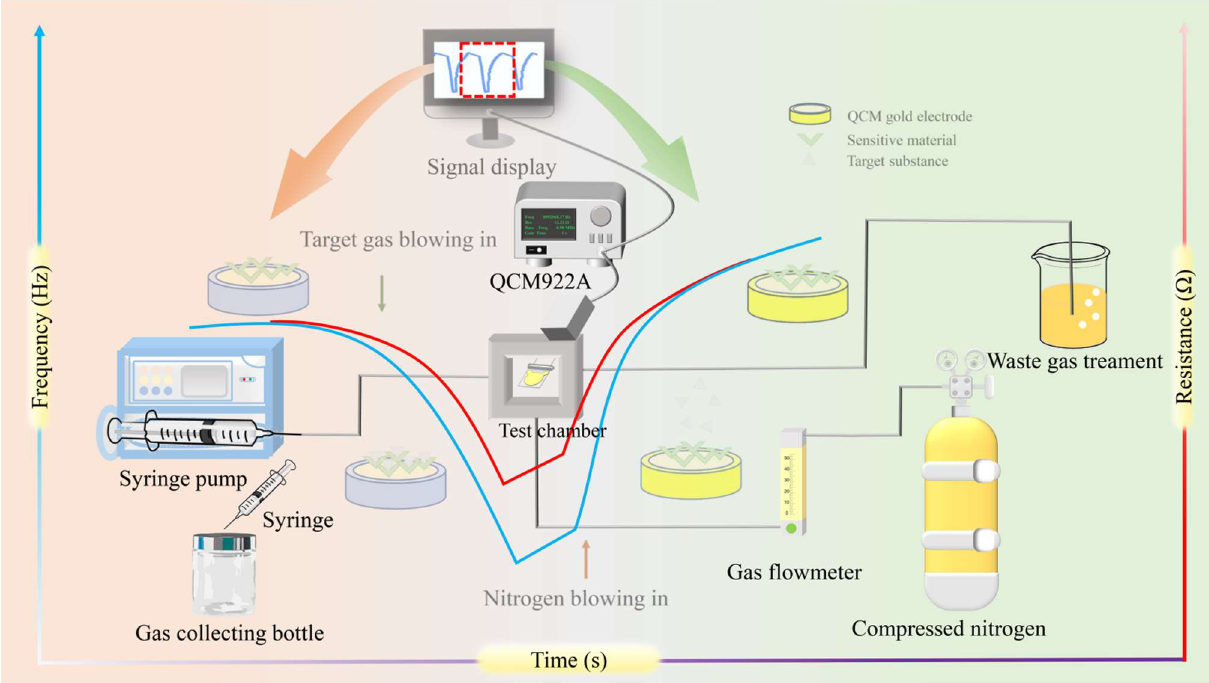
Figure 1. Schematic diagram of detection based on functionalized QCM sensor